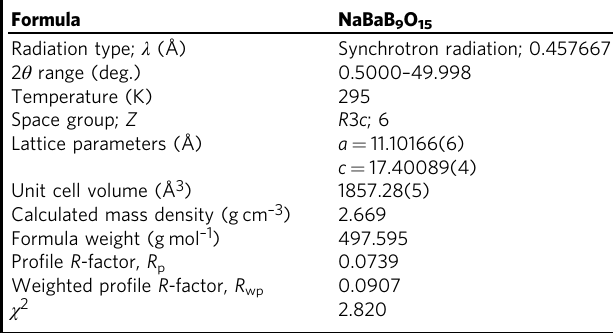
Table 1 Rietveld re fi nement data of NaBaB 9 O